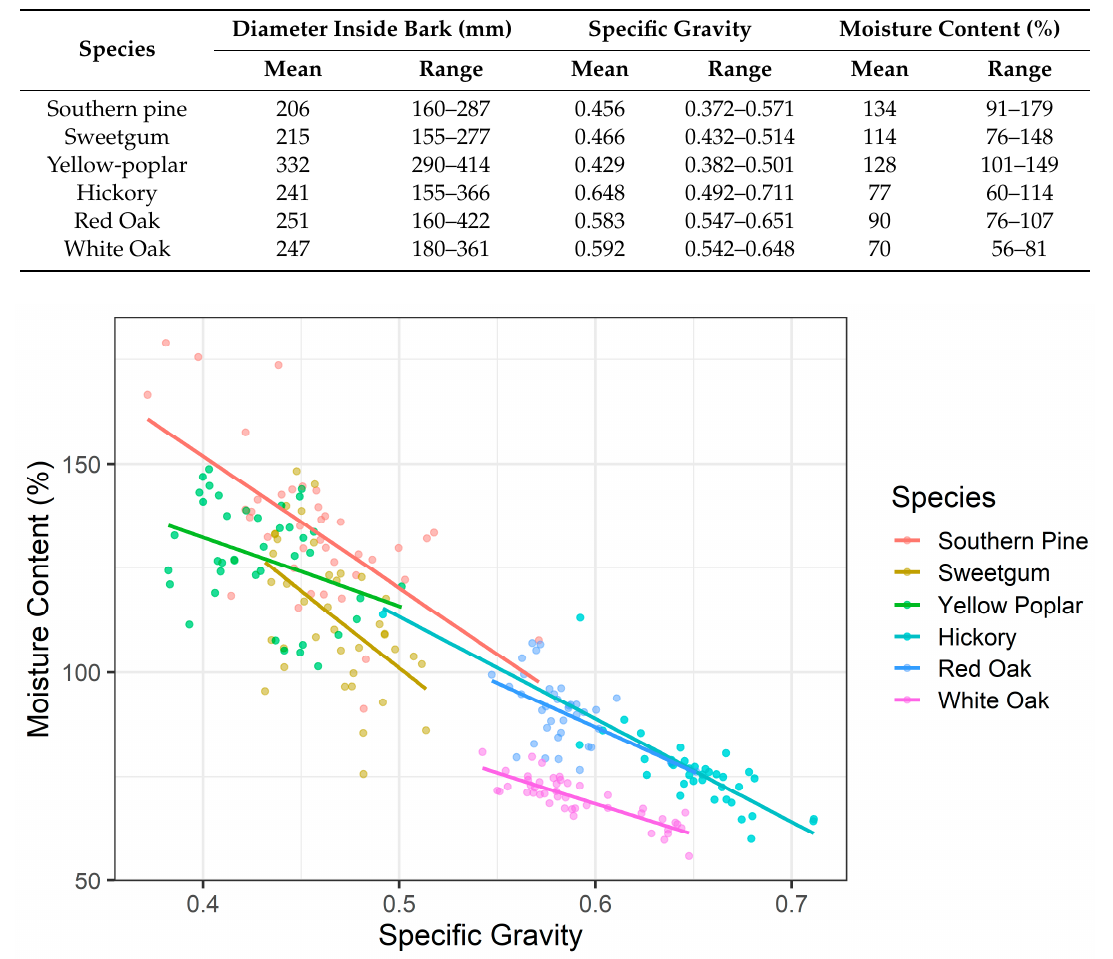
Figure 3. Moisture content after soaking versus specific gravity for the different species.